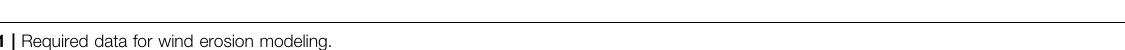
TABLE 1 | Required data for wind erosion